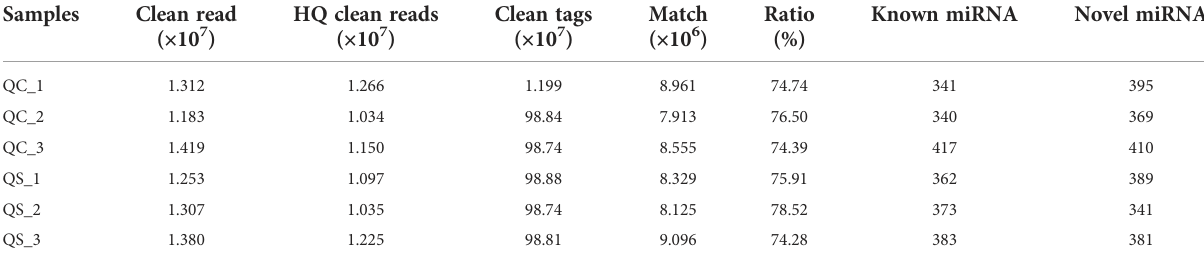
TABLE 2 The tags information after fi ltering in miRNA-seq.